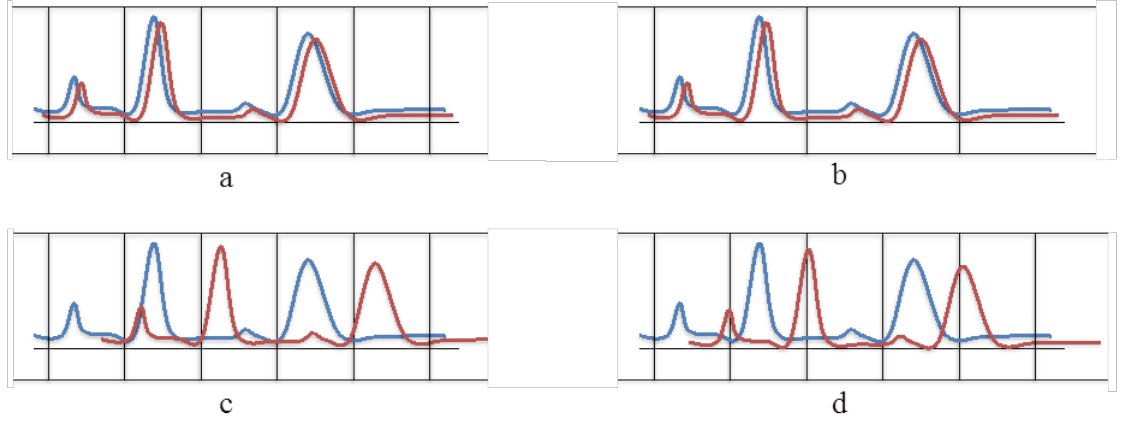
Figure 1. Hypothetical examples of how binning addresses peak shifts. ( a ) A good binning—each peak corresponding between the red and blue spectrum end up the same bin. ( b ) Multiple peaks end up in a single bin. ( c ) Incorrect matching of overlapping peaks—the first peak of the red spectrum falls in the same bin as the second peak of the blue spectrum. ( d ) Peak shifts across the boundaries of